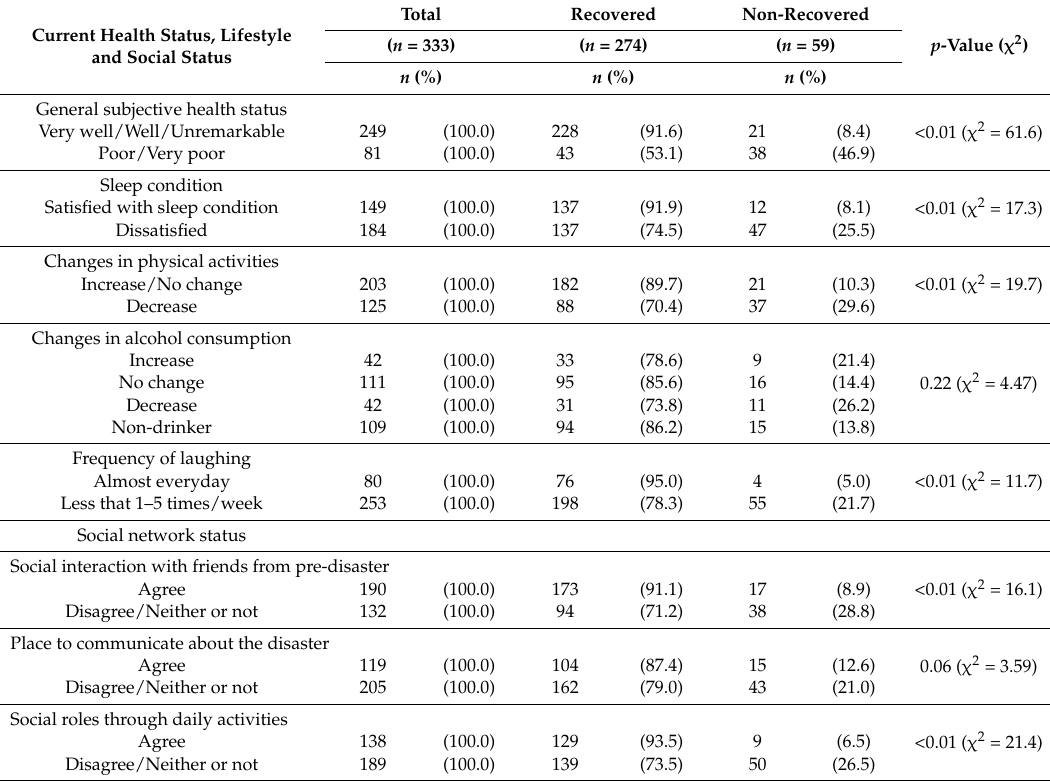
Table 4. Current health status, lifestyle, and social